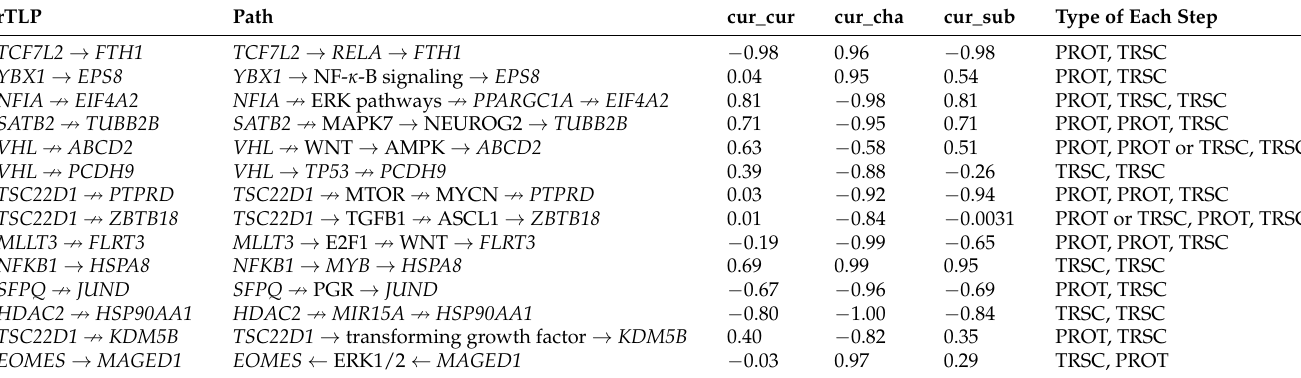
Table 3. Detailed paths of the causal pairs with regulatory